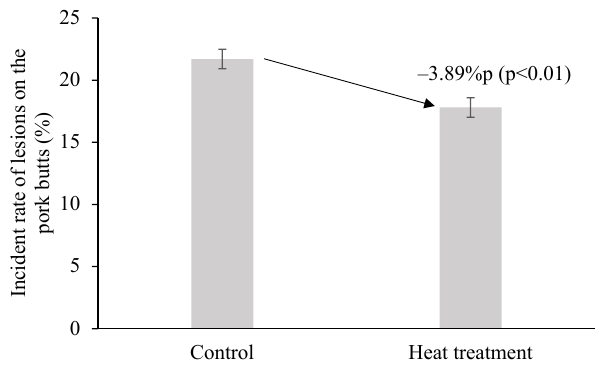
Figure 2. Proportion of discarded meat to dressed carcass (%) of pigs injected with foot-and-mouth disease vaccine after heat treatment at 40°C for 20 min. Error bars are standard error.